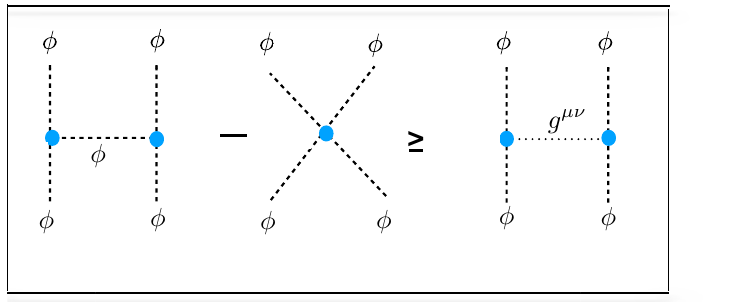
Figure 1 . Pictorial representation of the Strong Scalar Weak Gravity